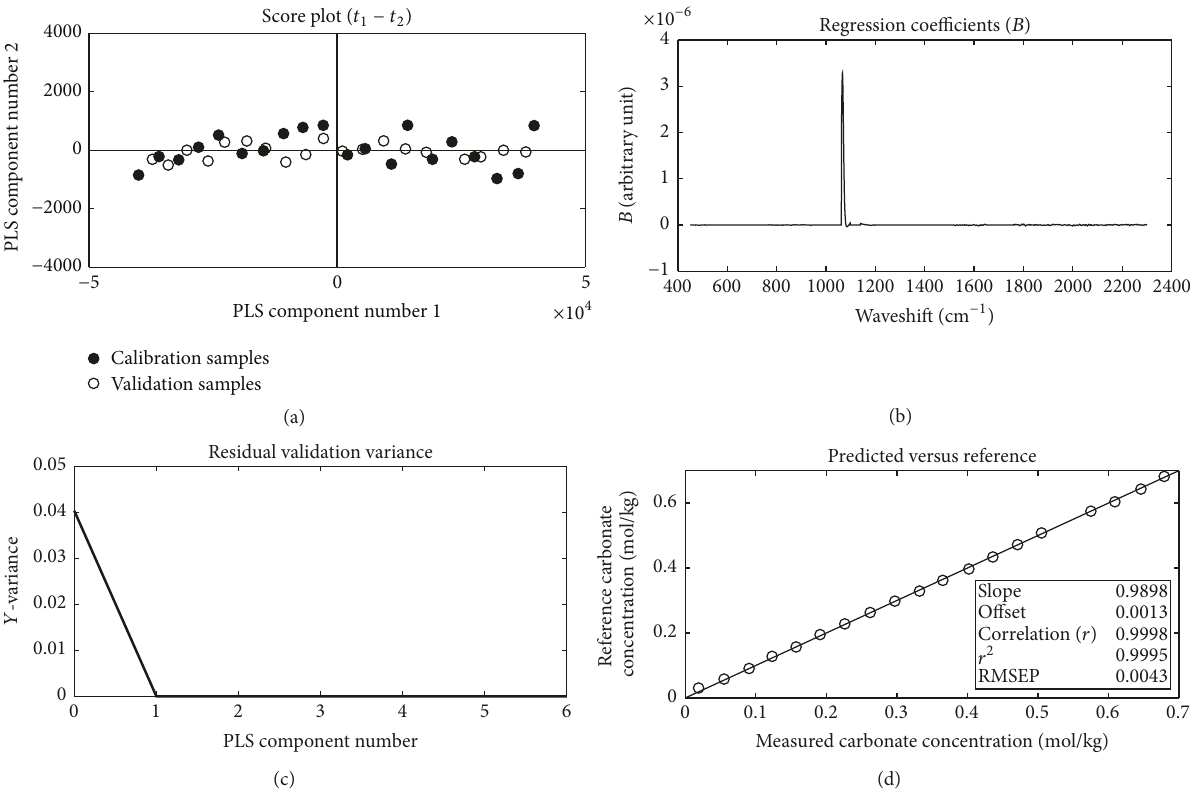
Figure 4: PLS-R model for carbonate. (a) Score plot of PLS components 1 versus 2 showing the calibration samples and validation samples. (b) Regression coefficients based on a one-component PLS-R model. (c) The residual validation variance shows that one PLS-component is optimal. (d) Predicted carbonate concentrations based on the one-component PLS-R model versus the reference concentrations obtained from the solute ion preparation stage.